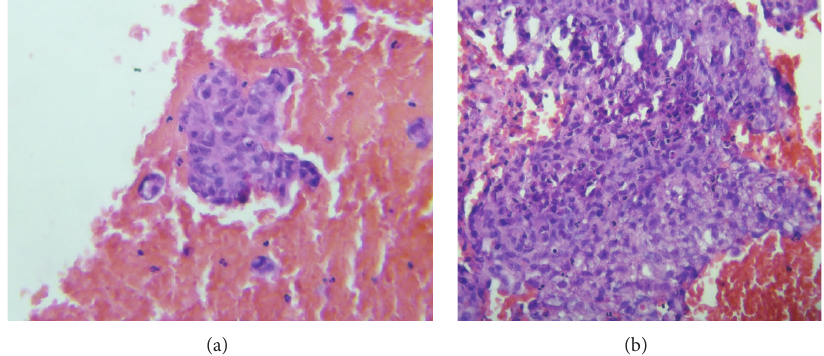
Figure 2: (a) and (b) Hematoxylin and eosin stain of the peripancreatic lymph node showing epithelioid granuloma.